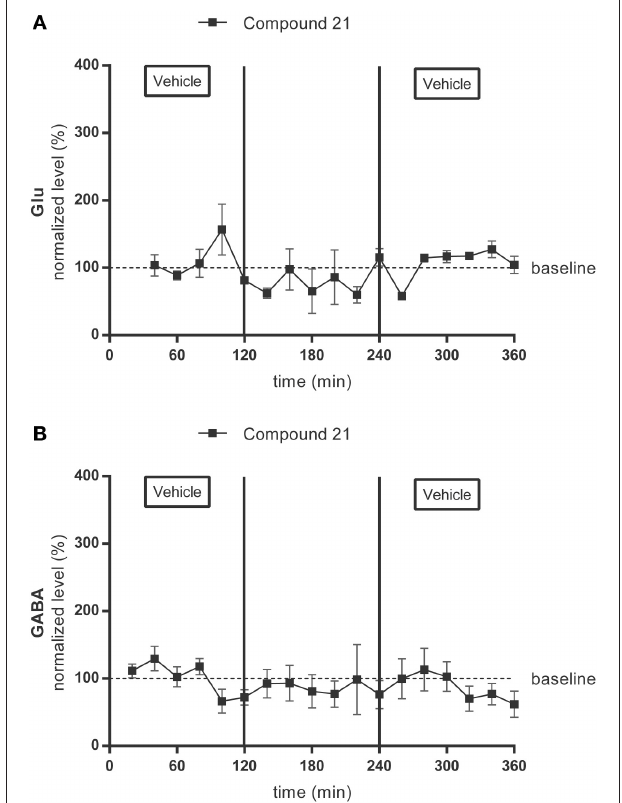
FIGURE 3 | Microdialysis experiment: effect of infusion with the AT2R agonist C21 (0.05 µ g/ µ l/h) on the extracellular glutamate (Glu) (A) ( n = 4) and GABA (B) ( n = 4) concentrations in the PVN in normotensive freely moving Wistar rats. Dialysates were collected every 20 min. C21 was dissolved in modified Ringer’s solution and administered through the dialysis probe from time 120 to 240 min. Data are presented as the mean percentage of the baseline values (vehicle) ± SEM. Statistical analysis for intragroup differences of the treatment is performed using one-way ANOVA for repeated measures and the Dunnett’s multiple comparison test.